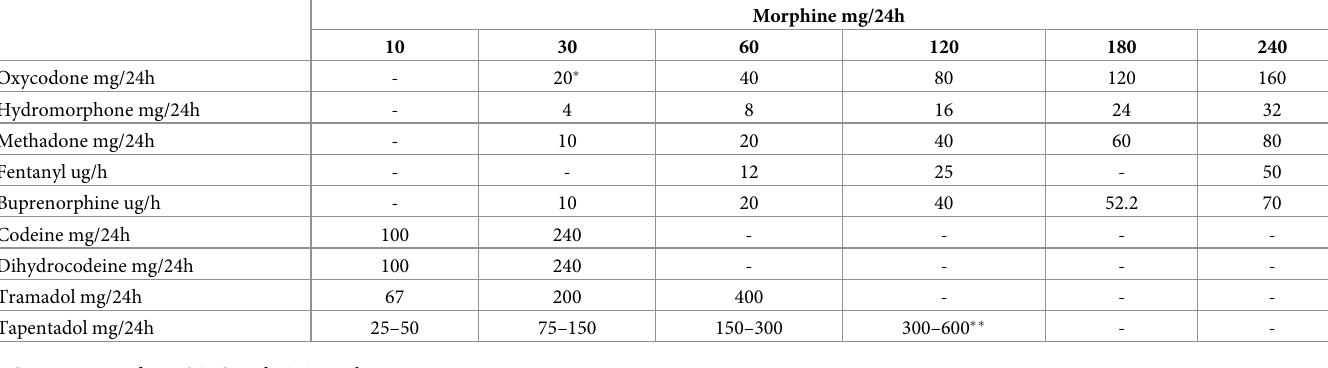
Table 1. Equivalence tables used in the calculation of DDD and